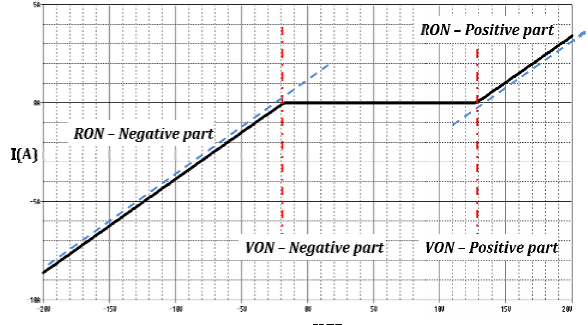
Figure 11: Basic of the “diode” model One part of the model is dedicated for positive part and the other one for negative part of the I/V char acteristic. Turn on value is managed by the voltage source and the dynamic resistor value can be tuned accordingly to the measured data.